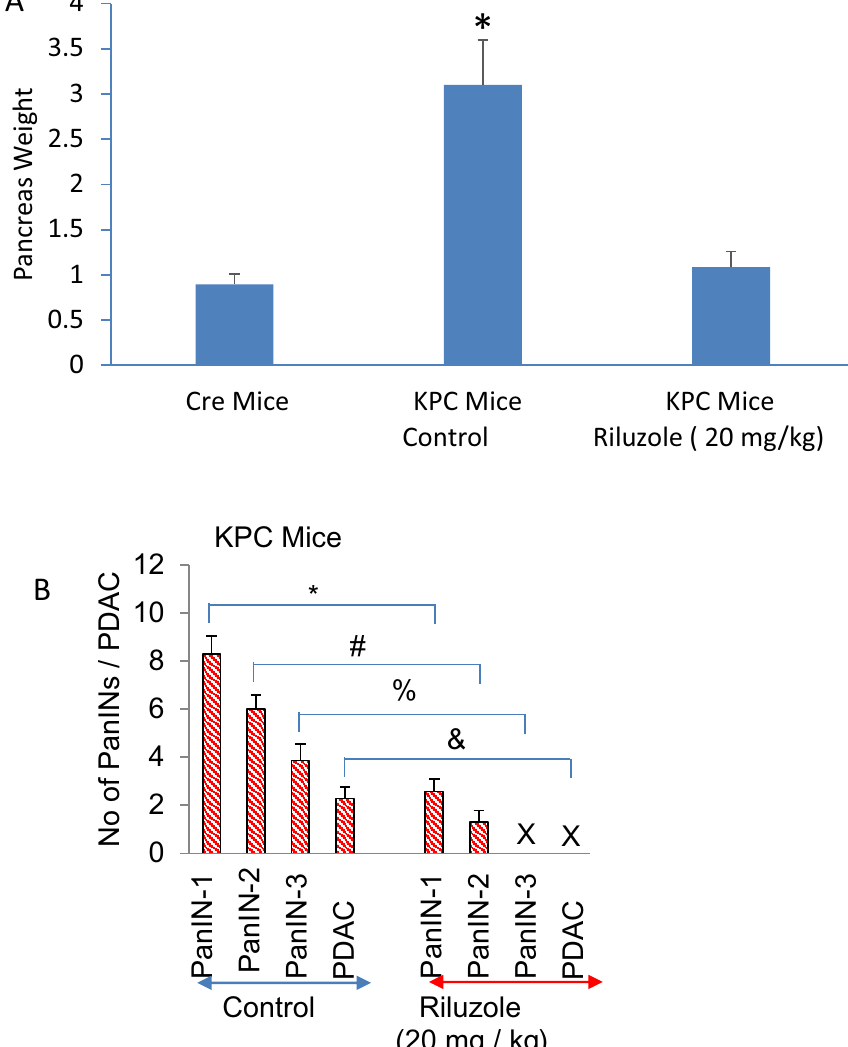
Figure 8. Riluzole inhibits pancreatic cancer growth in KPC (Pdx1-Cre, LSL-Trp53 R172H , and LSL-Kras G12D ) transgenic mice. KPC mice (about 6 weeks old) were injected ip with riluzole (20 mg/kg, Monday through Friday) for 12 weeks. At the end of the treatment, mice were sacrificed. ( A ) Pancreas Weight. Mice were euthanized and pancreas weight was taken from Cre mice (normal, untreated), KPC mice (control, untreated), and KPC mice (treated with riluzole 20 mg/kg). Data represent mean ± SD (n = 7). * and # = significantly different from control group; p < 0.05. ( B ), Histological examination of the pancreas was performed by H&E staining. Numbers of PanINs and PDAC were quantified. Data represent mean ± SD (n = 7). *, #, %, and & = significantly different from control group; p < 0.05. X = not